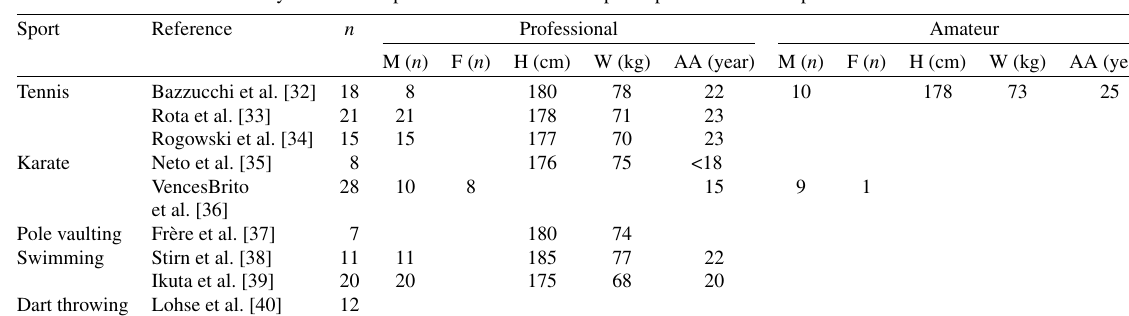
Table 3 Summary of the anthropometrics variables of the participants used in the sports-based